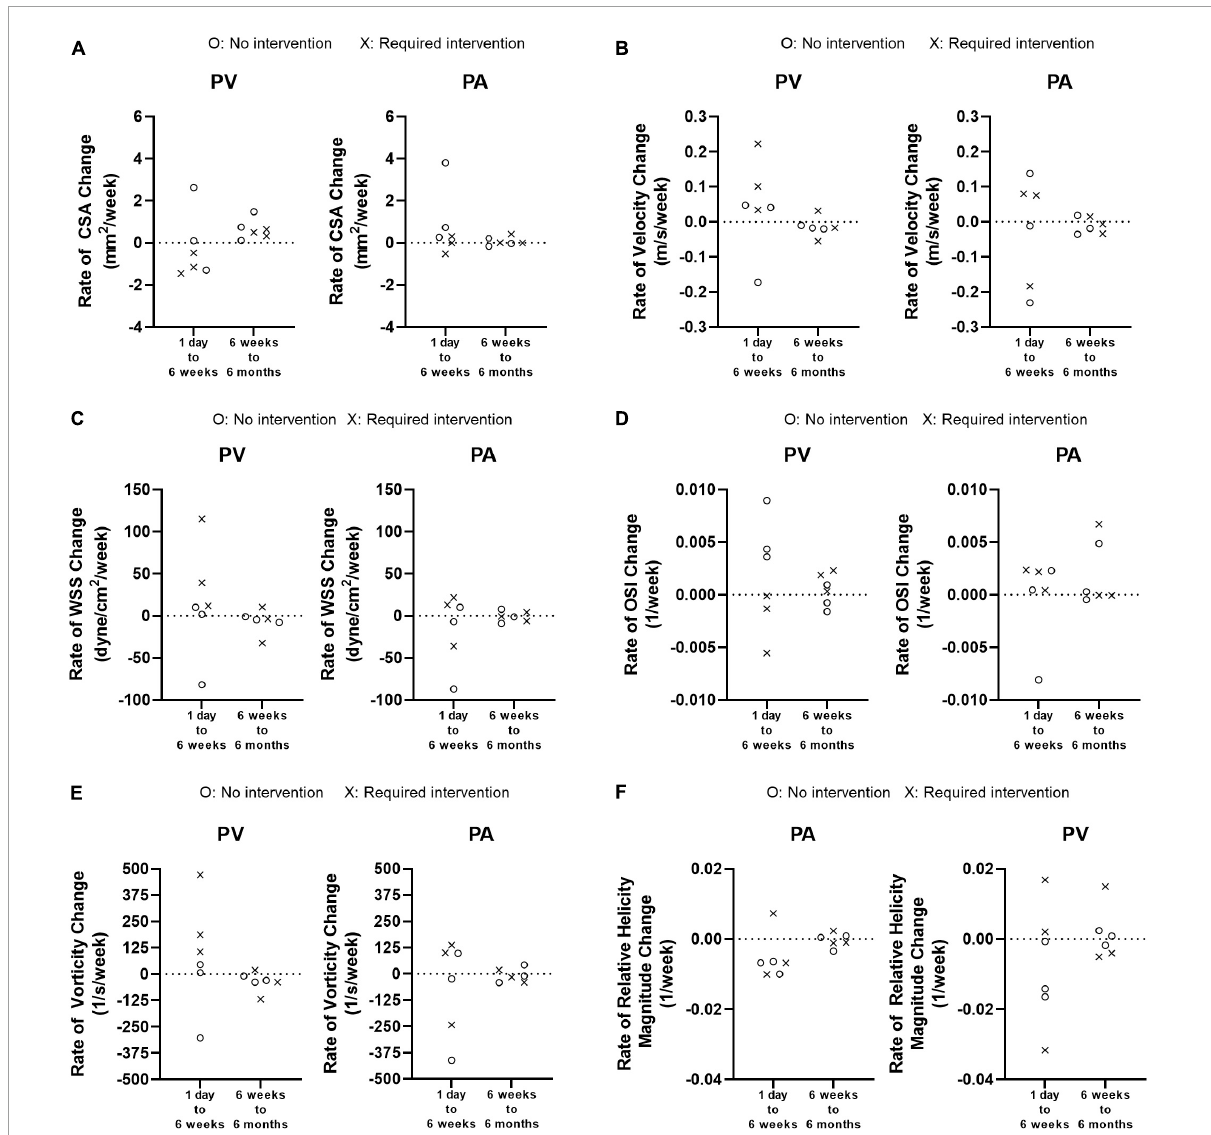
FIGURE8 Weekly rate of change from 1 day to 6 weeks and from 6 weeks to 6 months. (A) Cross-sectional area (CSA). (B) Velocity. (C) Wall shear stress (WSS). (D) Oscillatory shear index (OSI). (E) Vorticity. (F) Relative Helicity